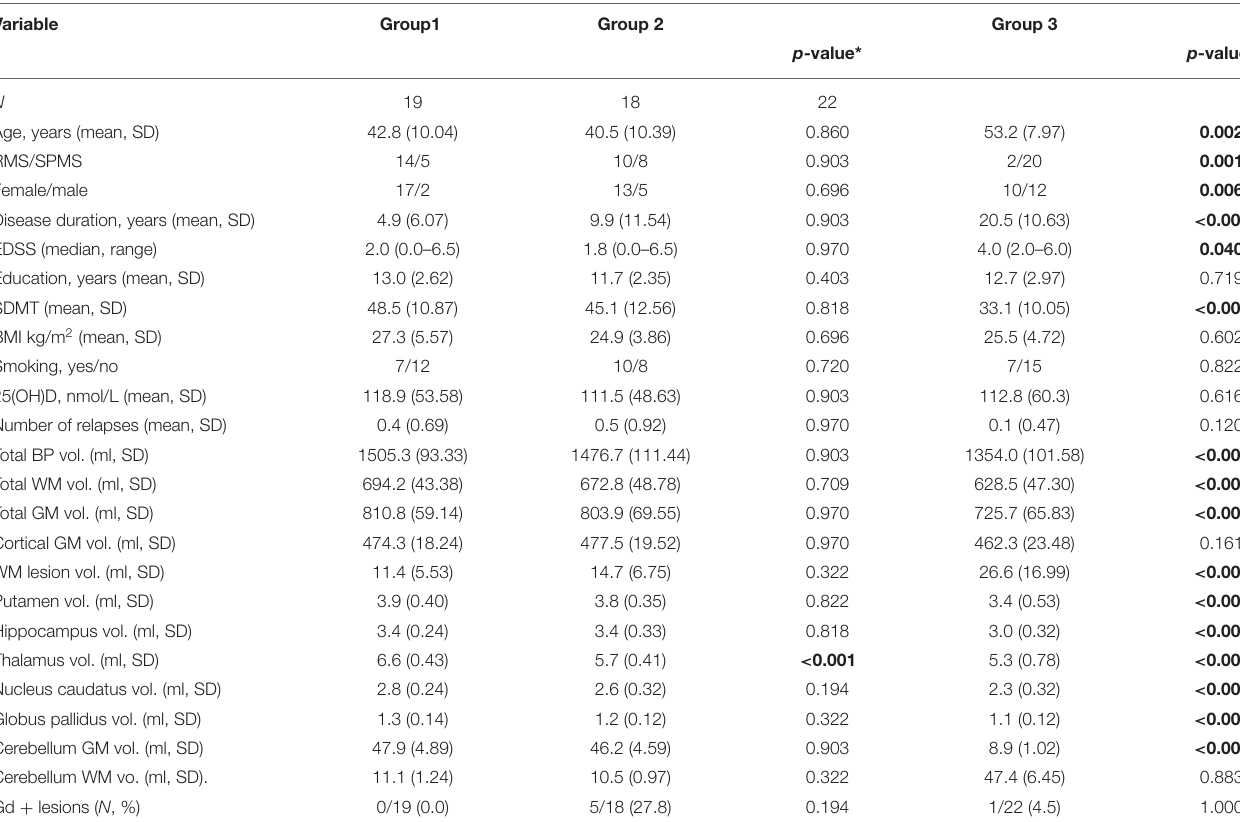
TABLE 1 | Baseline demographic, clinical, and MRI characteristics of the patients with and without thalamus atrophy. Variable Group1 Group